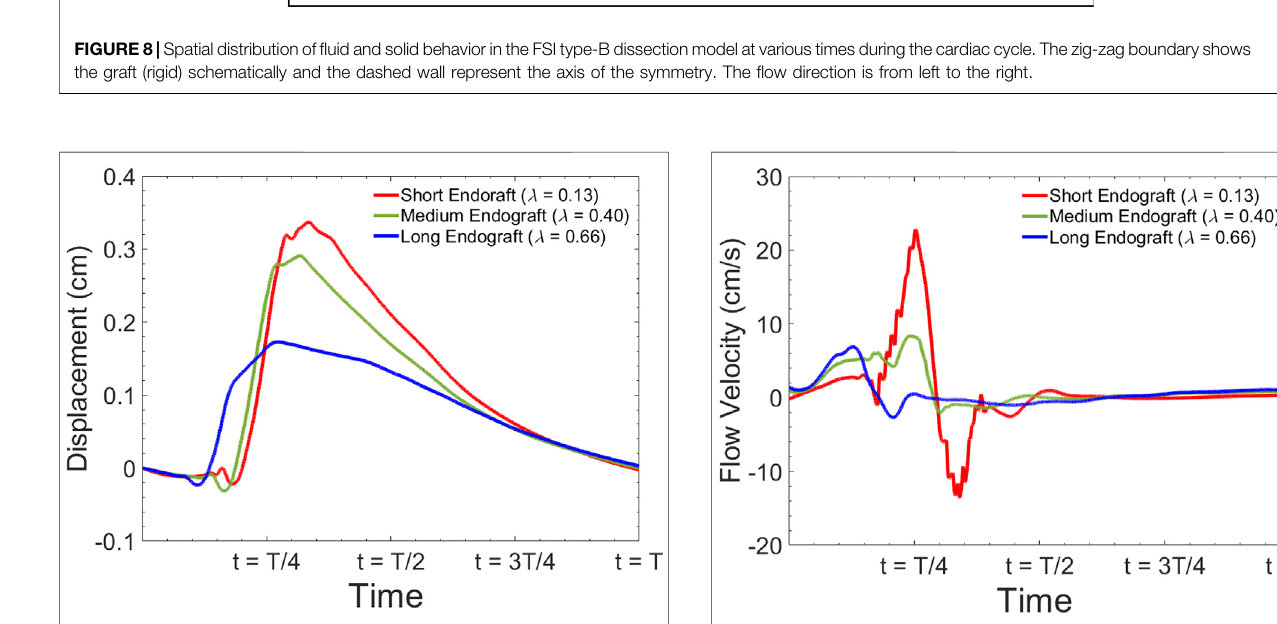
FIGURE10 | Simulated fl owvelocity waveform inside thefalse lumen for different graft lengths during one cardiac cycle. The data are collected 5 cm proximal to the distal